Question: Which kind of chart has been used to present this data?
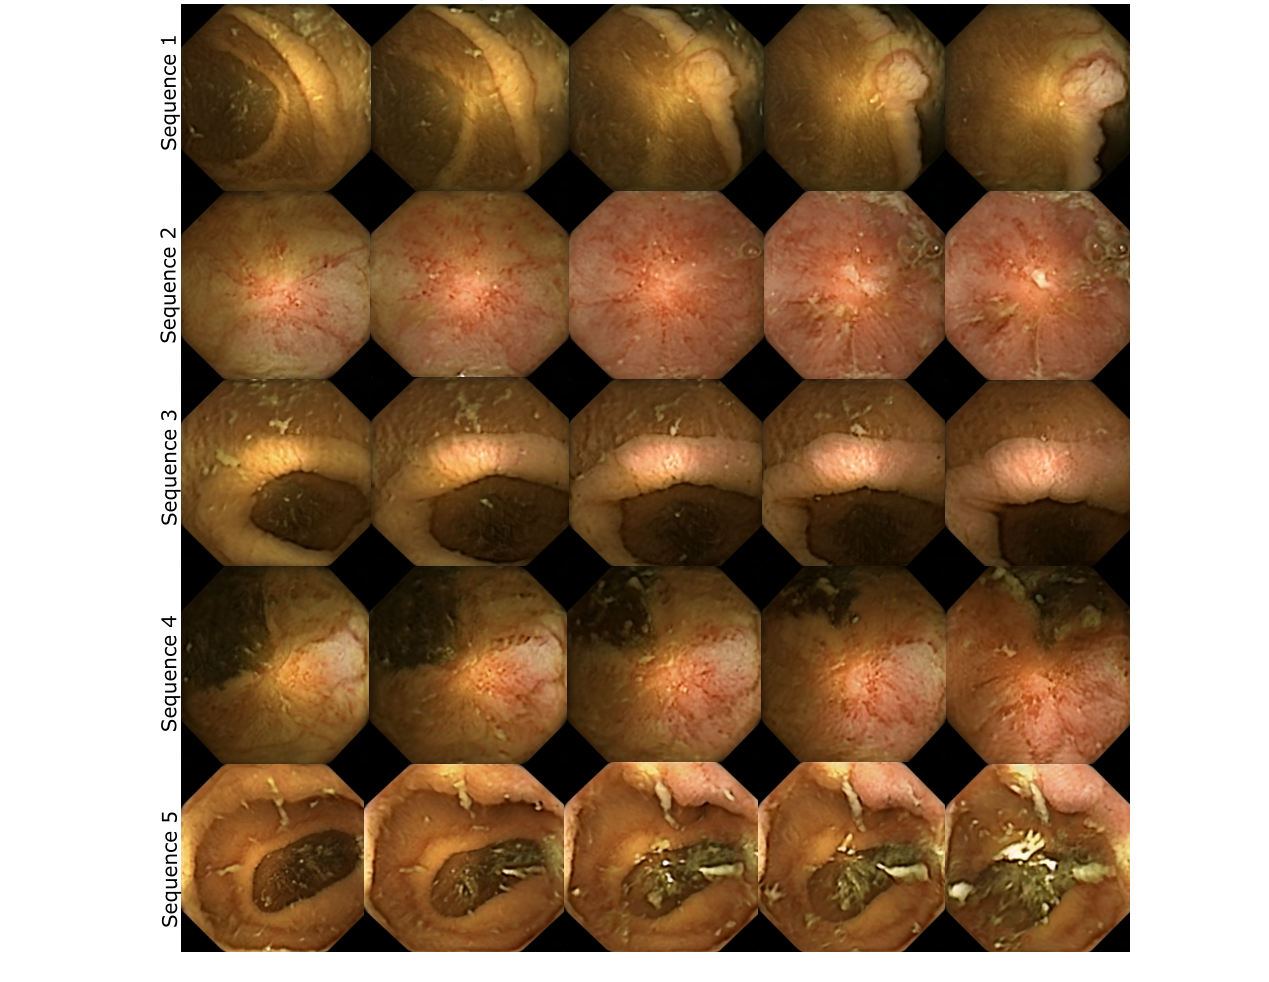
Answer: histogram